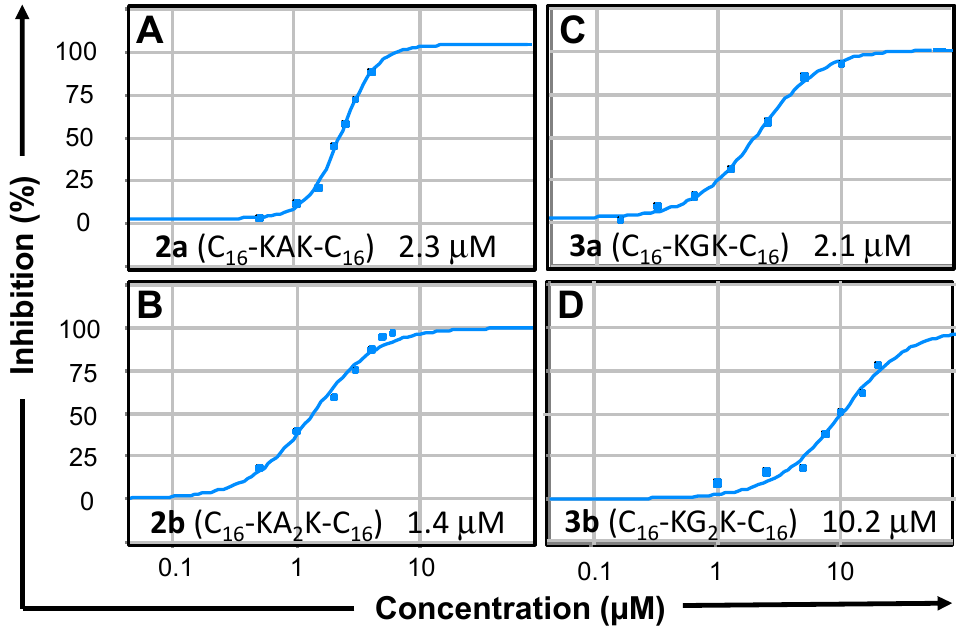
Figure 2. Inhibition of DENV2 protease by geminoids 2 (left: panel ( A ), compound 2a , panel ( B ), compound 2b ) and 3 (right: panel ( C ), compound 3a ; panel ( D ), compound 3b ). Dose-response curves (average of experiments performed in triplicate) for the biochemical assay with 50 µM Tyr(3-NO 2 ) substrate in 50 mM Tris–HCl, pH 9.0, ethylene glycol (10 % v / v ), Brij ® 58 (0.0016%). See insets and Table 1 for averaged IC 50 values from curve fits.